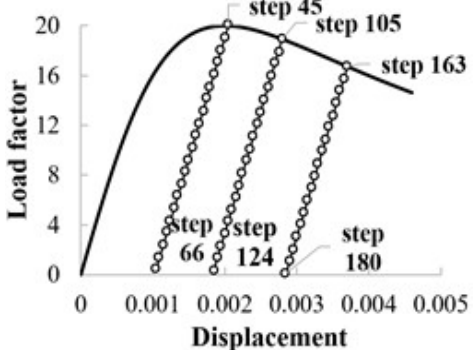
Figure 5. Cycle control - steps count.